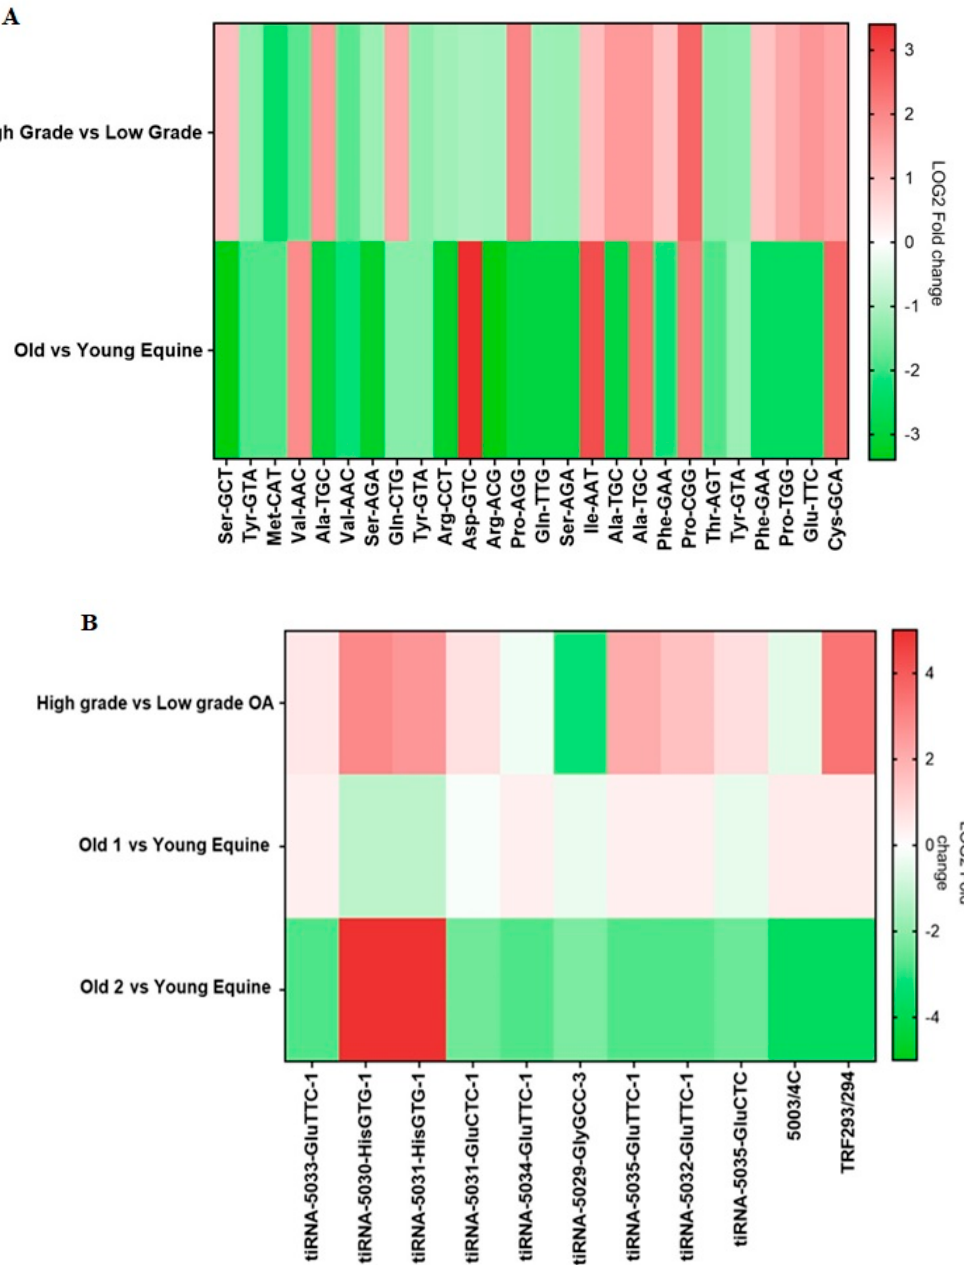
Figure 6. tRNA analysis of human osteoarthritic cartilage. ( A ) High grade versus low grade OA human cartilage and old versus young equine chondrocyte tRNA profiles. Heatmap of Log2 fold change expression of 26 tRNAs detected in both human and equine samples. Human cartilage tRNAs detected using a Human tRNA PCR Array. Red highlights induced tRNA expression in high grade OA human cartilage compared to low grade and in old equine chondrocytes compared to young. Green highlights reduced tRNA expression in high grade OA human cartilage compared to low grade and in old equine chondrocytes compared to young. ( B ) High grade OA versus low grade OA human cartilage and equine tiRNA / tRF profiles. Heatmap of Log2 foldchange expression of 11 tRF / tiRNA fragments detected in both human and equine samples. Human cartilage tRF / tiRNA detected using a Human tRF&tiRNA PCR Array. Red highlights induced tRF / tiRNA expression in human high grade versus low grade OA samples and in old versus young equine samples. Green highlights reduced tRF / tiRNA expression in human high grade versus low grade OA samples and in old versus young equine